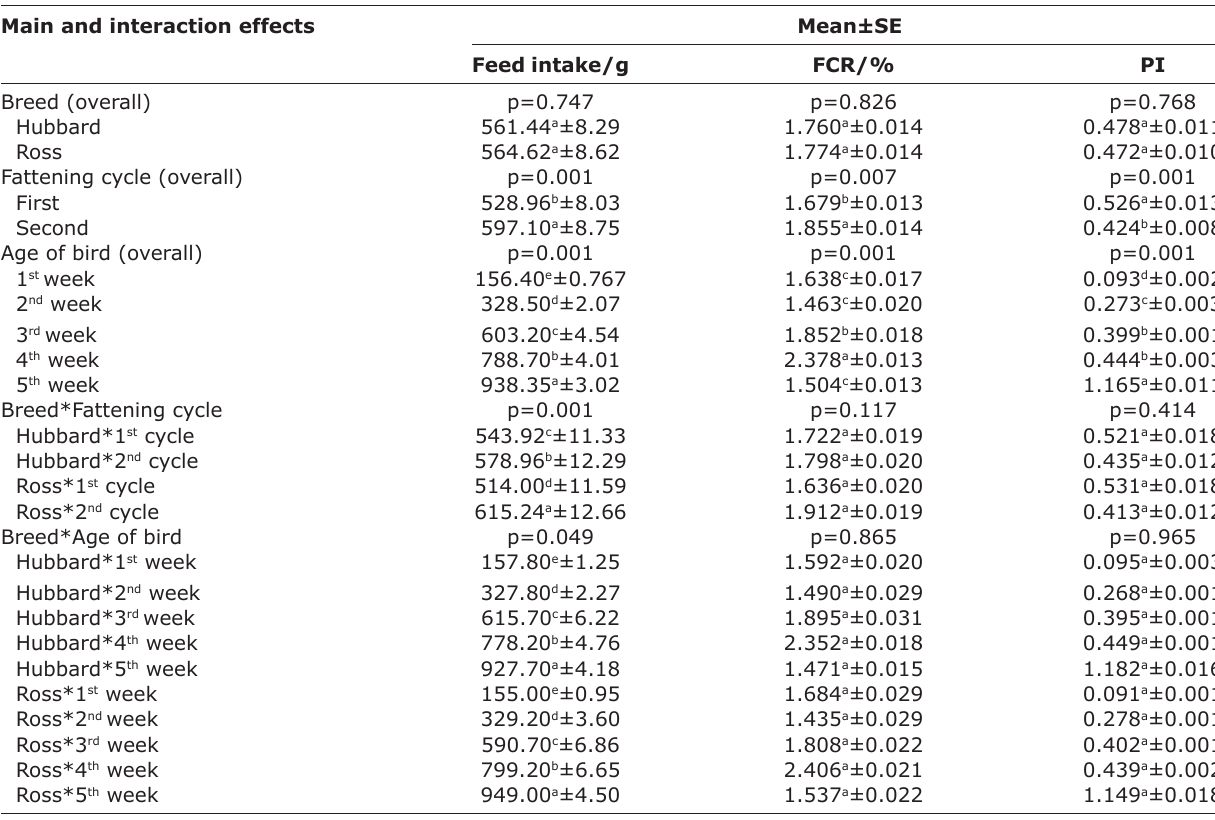
Table 2: Effects of breed, fattening cycle, age of birds (weeks) and of their interactions on feed intake, FCR, and PI. Main and interaction effects